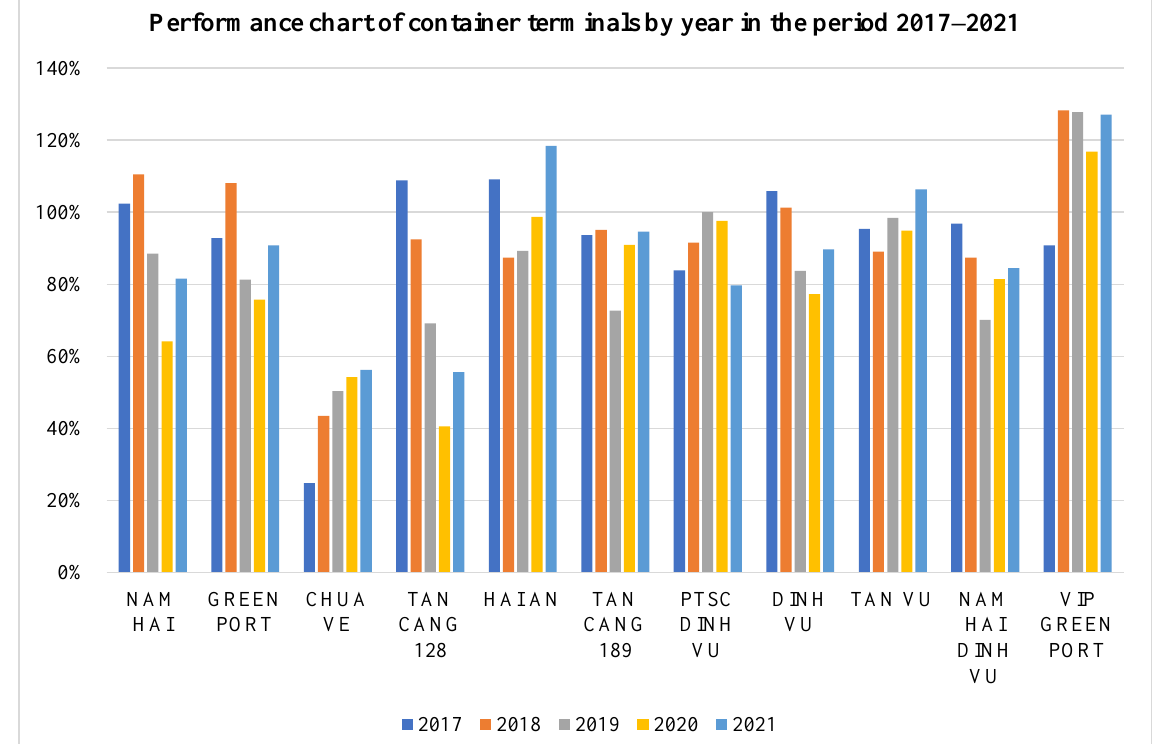
Figure 4. Container terminals’ performance.